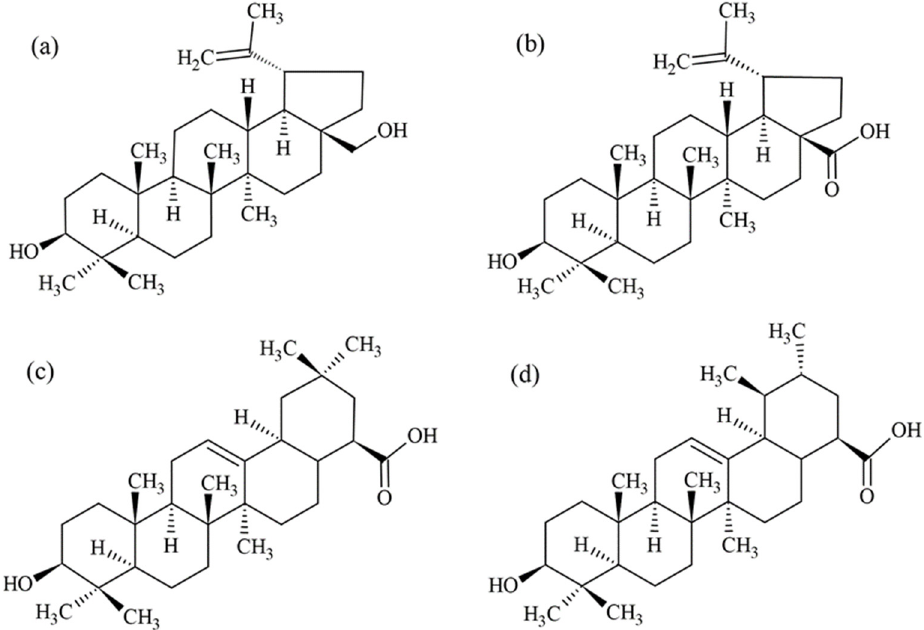
Figure 1. Chemical structures of betulin ( a ), betulinic acid ( b ), oleanolic acid ( c ), and ursolic acid ( d